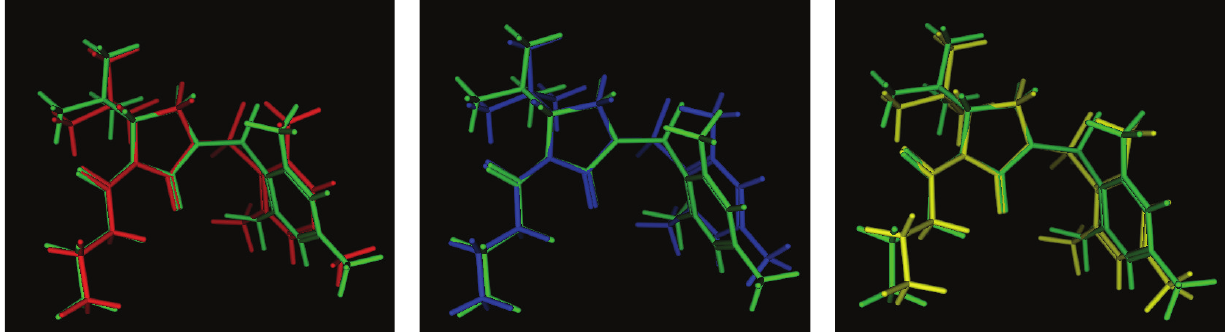
Figure 6: The superposition of the theoretical model ( conformer - A (colors green))and the three molecules (molecule 3A , colors blue, molecule 3B : colors yellow, and molecule 3C : colors red) of X-ray structure of compound 3